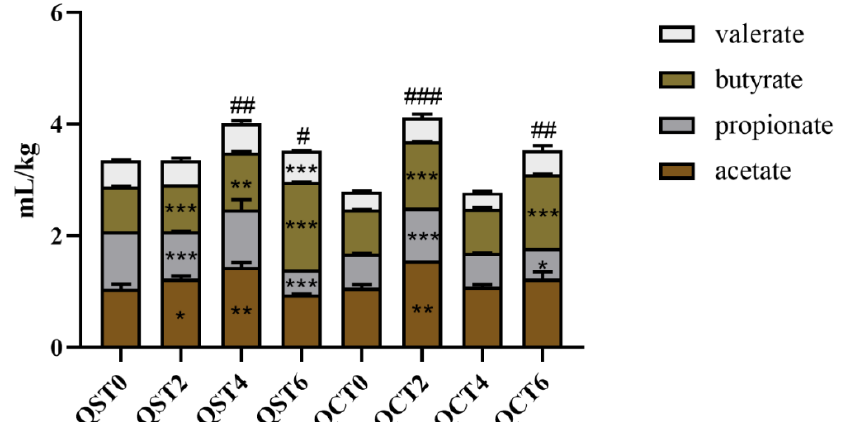
Figure 8. Content of SCFA in intestinal mucosa (QST—aqueous extraction group, QCT—alcohol extraction group. Comparison of SCFA between groups: * p < 0.05 ** p < 0.01 *** p < 0.001. Total acid contrast: # p < 0.05, ## p < 0.01, ### p < 0.001, compared with Day 0 for significant differences. 0—no sample added; 2, 4, 6 denote fermentation days after sample addition).